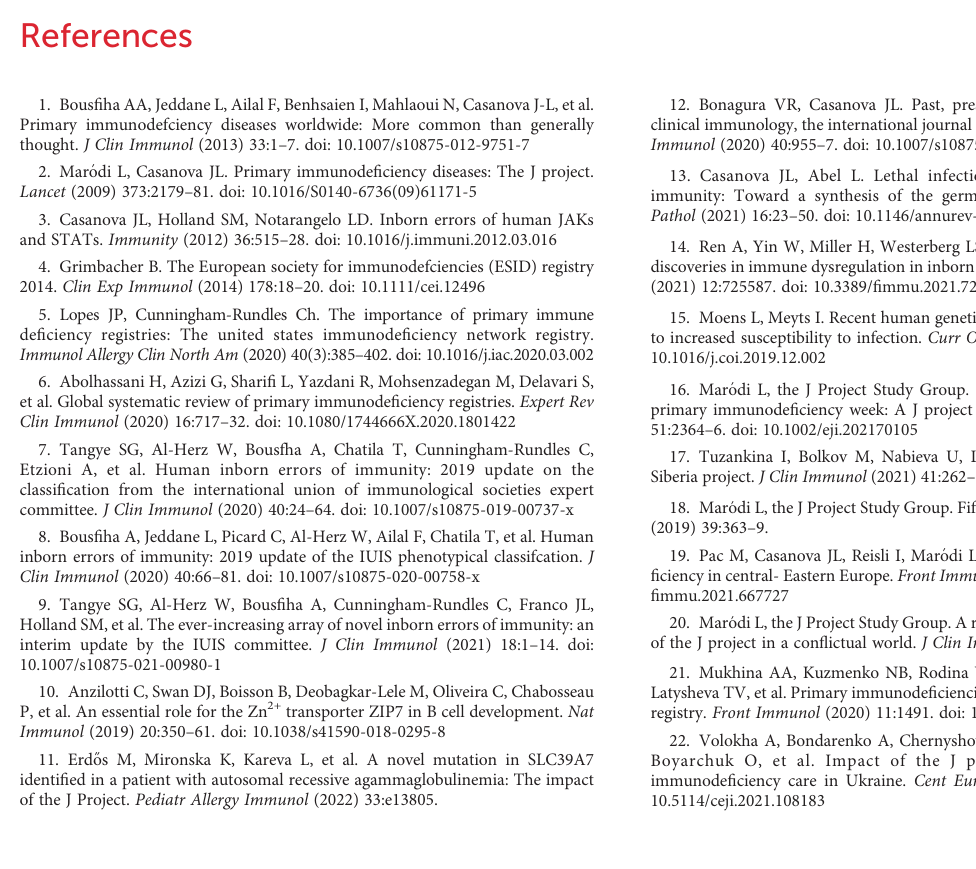
SUPPLEMENTARY FIGURE 1 The fi rst J Project (JP) Steering Committee meeting in 2010, chaired by (from L to R) I Reisli, M Serban, L Maro ́ di (center), I Tuzankina, M Pac, and A Bondarenko. Delegates from all JP member countries, 19 at that time, attended the meeting in order to discuss previous achievements and future challenges of the JP. SUPPLEMENTARY FIGURE 2 Geographic extension of the J Project by 2020 which included 32 countries and 6 J Daughter (JD) Project regions chaired by N Rezaei (JD Persia, 2009), I Reisli (JD Anatolia, 2009), A Elmarsha fi and N Galal (JD